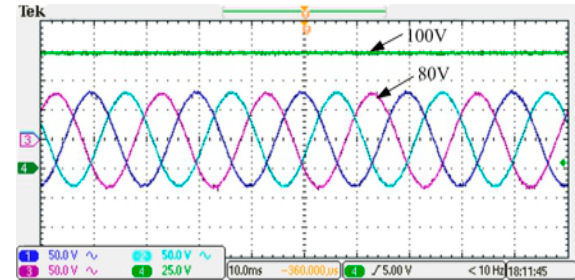
Figure 21. DC voltage waveform and inverter side filter voltage waveform.